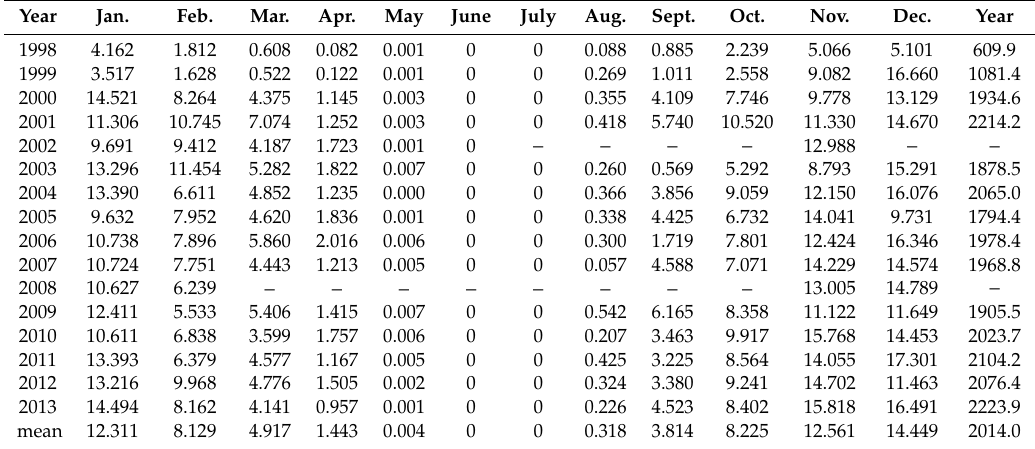
Table 3. Daily monthly mean and annual mean values of DNI [kWh · m − 2 ] estimated from GHI at Eneide (MZS) meteorological